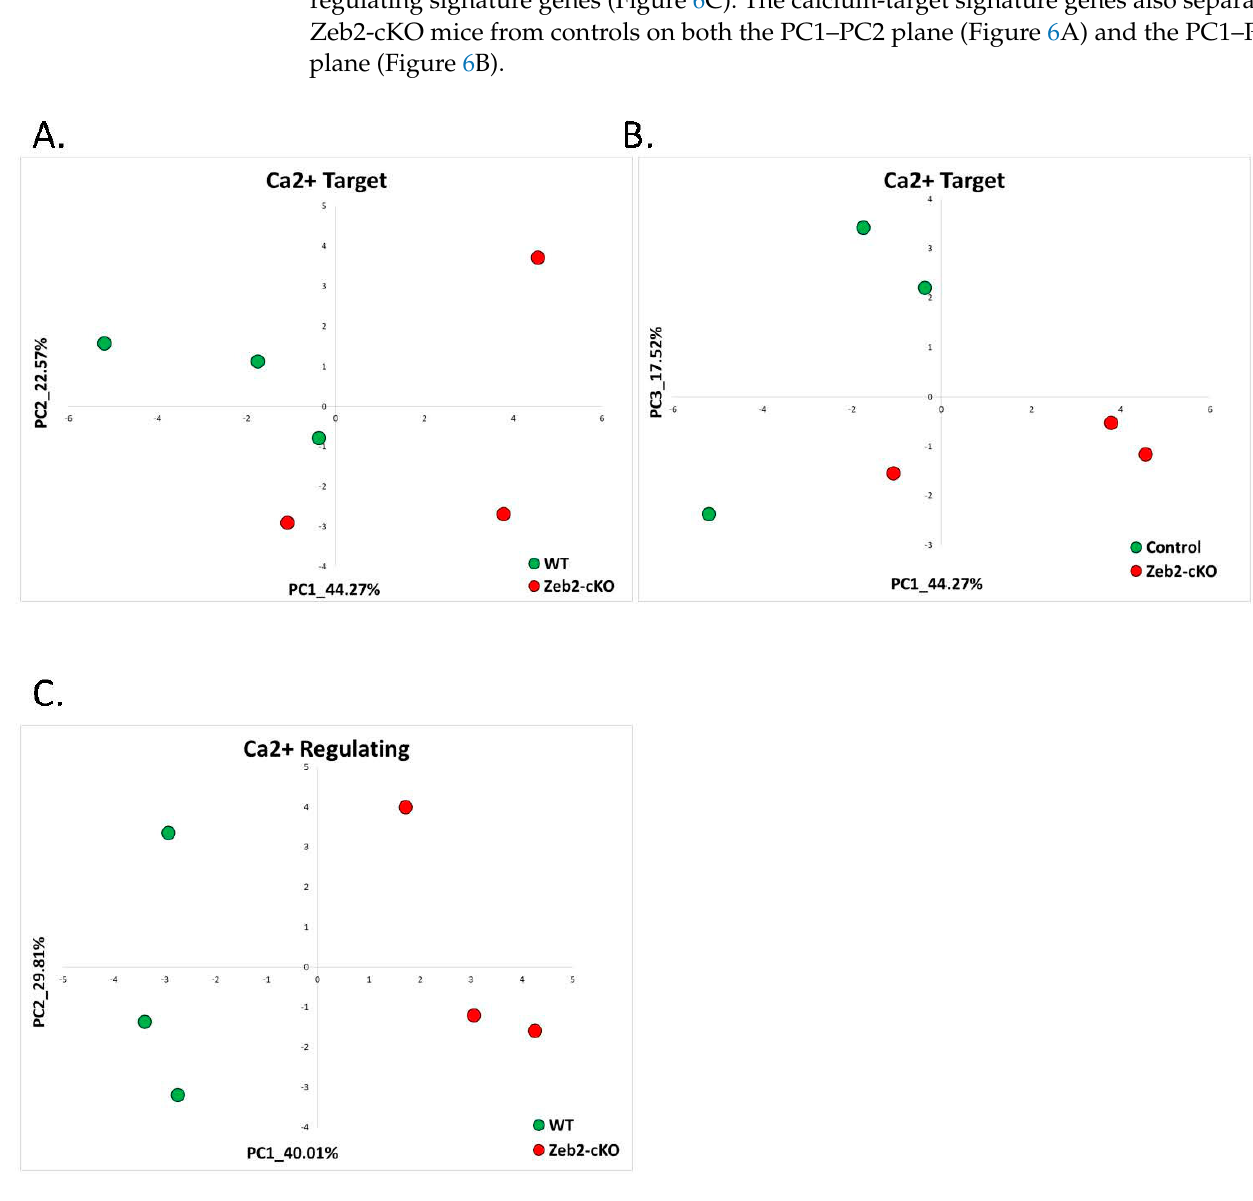
Figure 6. Mowat-Wilson Syndrome: calcium target and calcium regulating signatures. ( A ) PCA based on the expression of calcium-target signature genes in the cerebellum of Zeb2-cKO (deletion of the Zeb2 gene in cerebellar neural progenitors) mice right after birth (P0) and their wild-type (WT) controls. The separation of samples on the PC1–PC2 plane. The control samples are denoted in green, while the Zeb2-cKO samples are in red. ( B ) PCA based on the expression of calcium-target signature genes in the cerebellum of Zeb2-cKO (deletion of the Zeb2 gene in cerebellar neural progenitors) mice right after birth (P0) and their wild-type (WT) controls. The separation of samples on the PC1–PC3 plane. The control samples are denoted in green, while the Zeb2-cKO samples are in red. ( C ) PCA based on the expression of calcium-regulating signature genes in the cerebellum of Zeb2-cKO (deletion of the Zeb2 gene in cerebellar neural progenitors) mice right after birth (P0) and their wild-type (WT) controls. The control samples are denoted in green, while the Zeb2-cKO samples are in red.